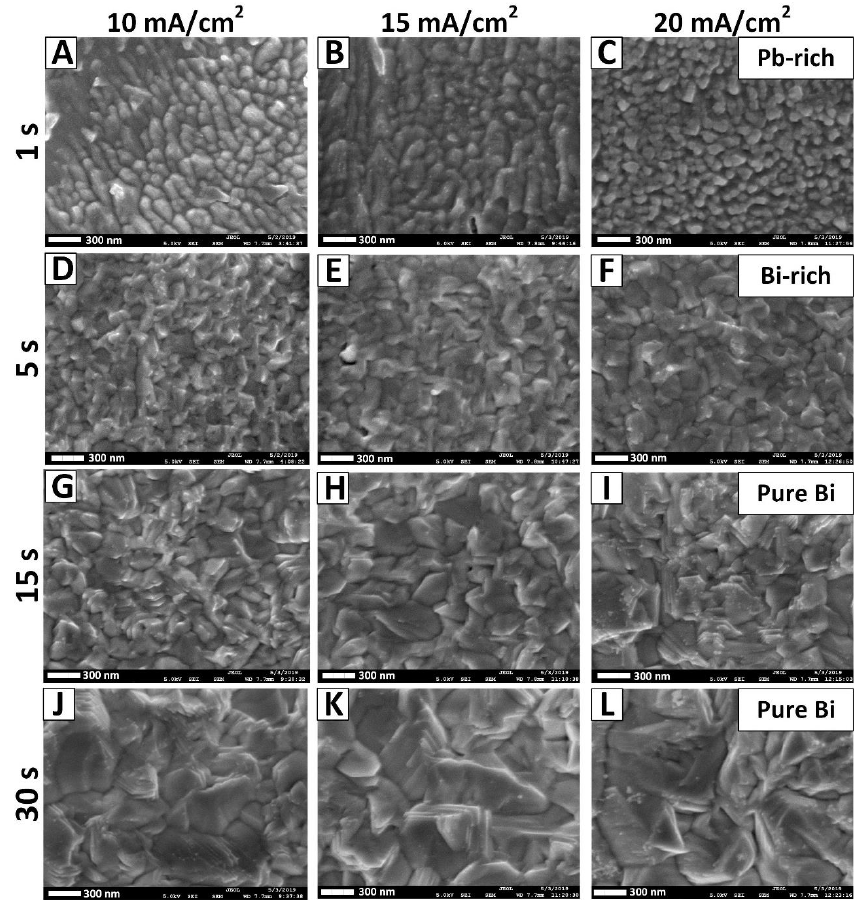
Figure 4. SEM images of films surface electrodeposited from PE with 10 mA/cm 2 ( A , D , G , J ), 15 mA/cm 2 ( B , E , H , K ), and 20 mA/cm 2 ( C , F , I , L ) current density, and the deposition duration of 1 s ( A – C ), 5 s ( D – F ), 15 s ( G – I ), and 30 s ( J – L ).